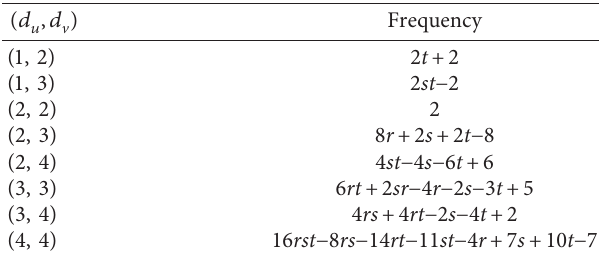
Table 2: Degree-based edge partition of M [ r, s, t ] for r,s, t ≥